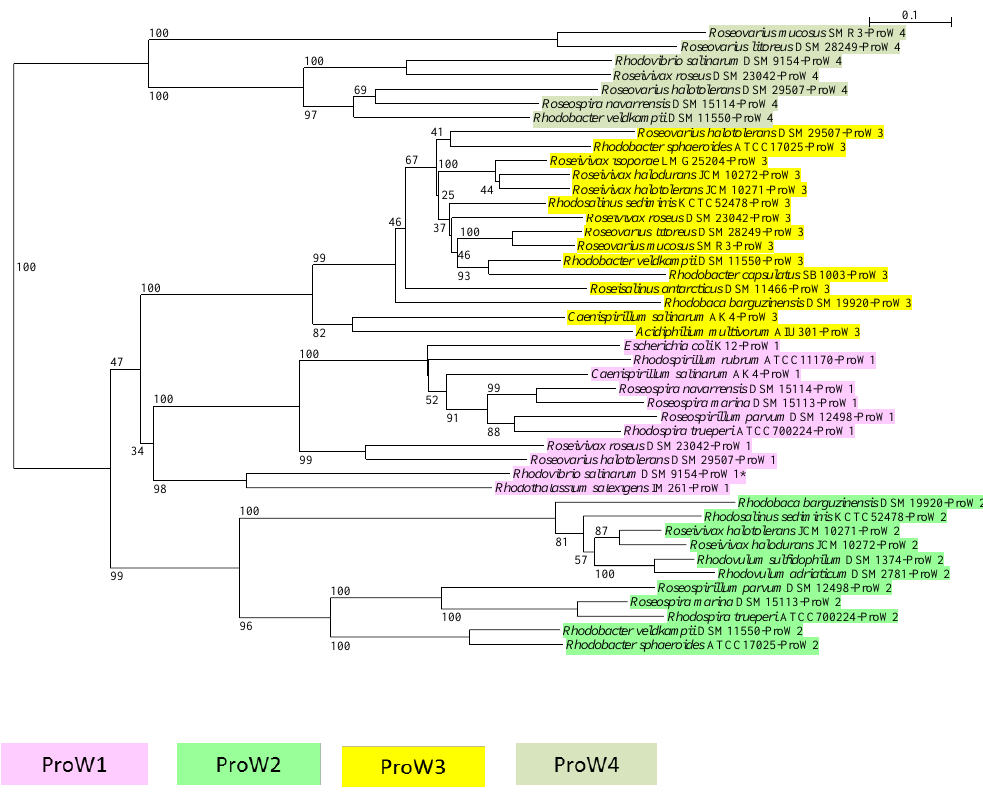
Figure 3. The phylogeny of the permease protein ProW of the L-proline/glycine betaine transport system ProU is shown in a neighbor-joining tree. The ProW1-ProW4 gene clusters are defined with Table 1. Sequences and gene bank accession numbers are shown in Supplementary Table S3. Bootstrap values expressed as percentages of 1000 replications are given at the branches. The bar indicates an evolutionary distance of 0.1. The following color code is used for the different ProW sequence types.